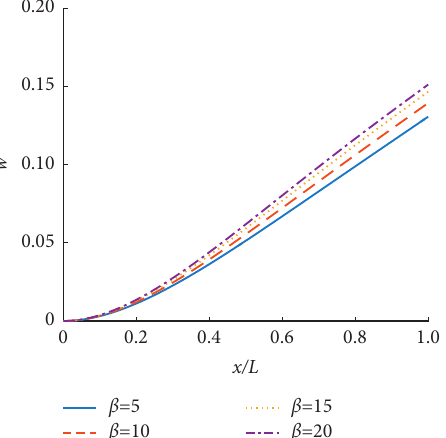
Figure 13: Influence of the parameter β on the deflection amplification factor at different locations of the